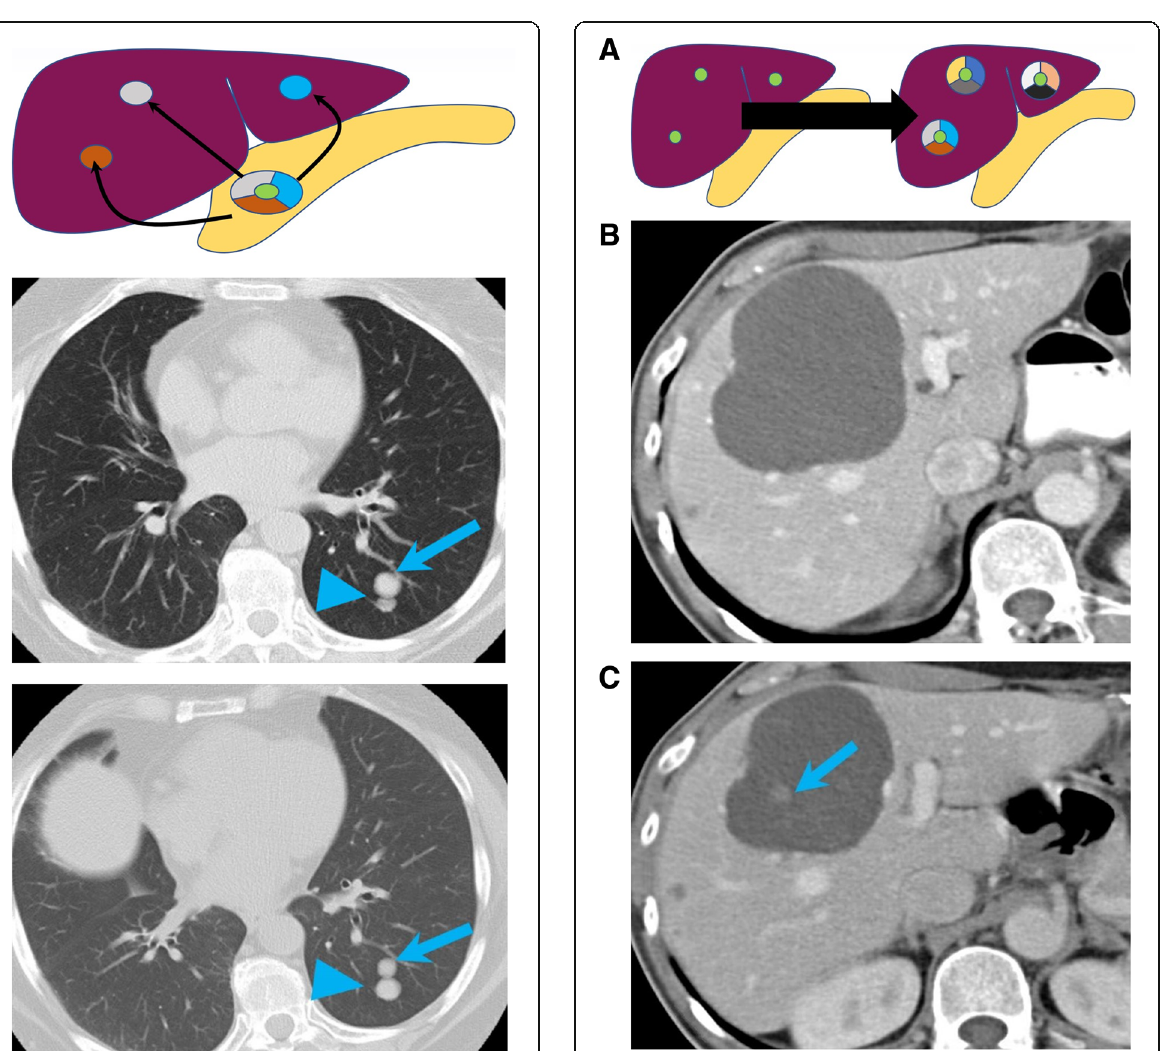
(d) Interpatient heterogeneity: heterogeneity among